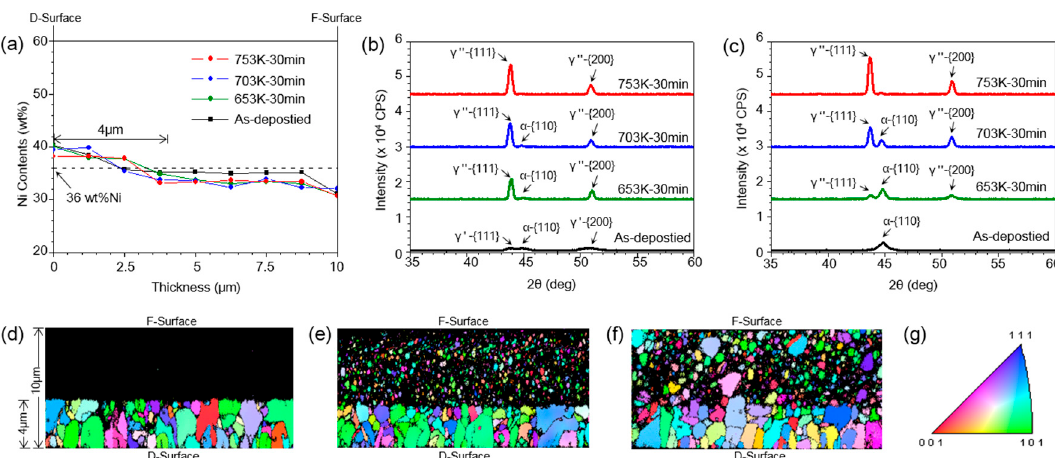
Figure 2. Annealing phenomena in the electroformed Fe-Ni alloy with a through-thickness compositional gradient. ( a ) The concentration profile along the thickness direction. ( b , c ): XRD data collected for the D-surface ( b ) and F-surface ( c ) show the phases developing in the as-deposited and as-annealed states. In the as-deposited state, the α and γ′ phases coexist in the composition range between 36 and 40 wt % Ni, and the single α phase exists in the compositions with less than 36 wt % Ni. In the as-annealed state, the γ″ phase appears. ( d – f ): The evolution of the α → γ″ phase transition is observed by comparing the EBSD maps collected for the cross-section of the samples annealed at 653 K for 3 min ( d ), 703 K for 30 min ( e ) and 753 K for 30 min ( f ). Abnormal grain growth occurs only in the nanostructured γ′ phase with a Ni content >36 wt %, corresponding to a distance approximately 4 µ m from the D-surface ( d ); the α phase maintains the nanocrystalline state, dark area in the EBSD map. The grown grains, in ( e , f ), result from the α → γ″ phase transition.